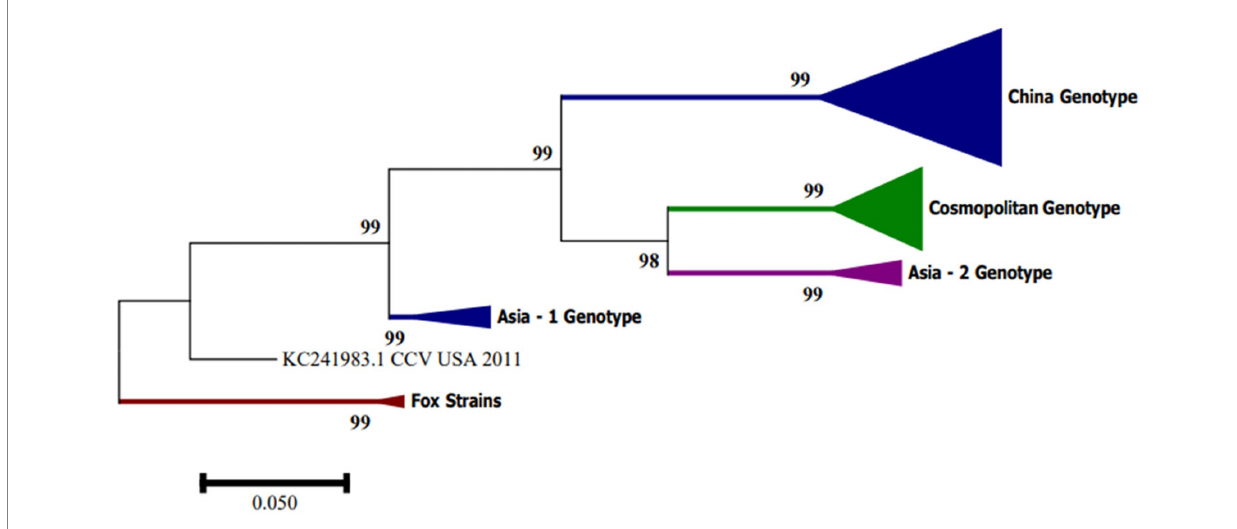
FIGURE 3 Phylogenetic tree based on complete CanineCV genome sequences. The phylogenetic analysis was performed using MEGA 7.0 for Windows by maximum likelihood with 1,000 bootstrap replicates and the 3-parameter Tamura nucleotide substitution